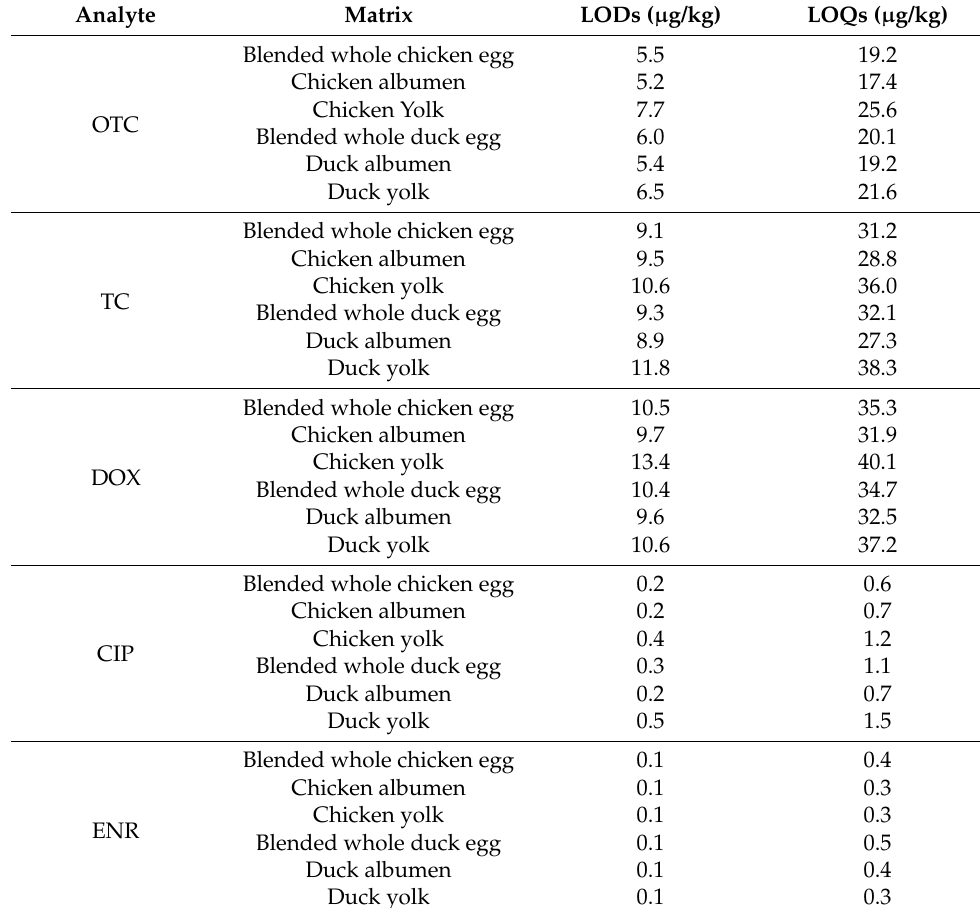
Table 8. LODs and LOQs of OTC, TC, DOX, CIP and ENR in poultry